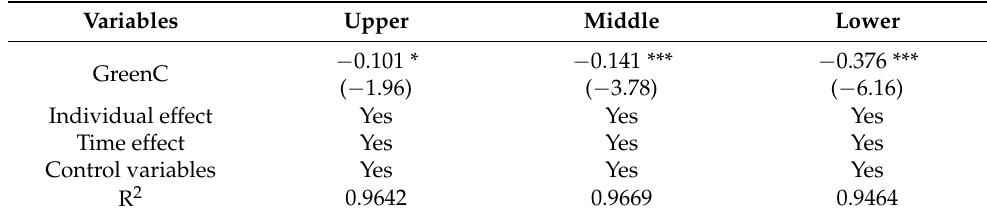
Table 8. Regression results for regional